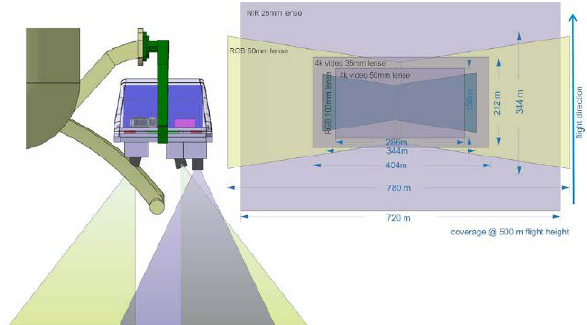
Figure 3: Field of view and coverages of the 4k camera